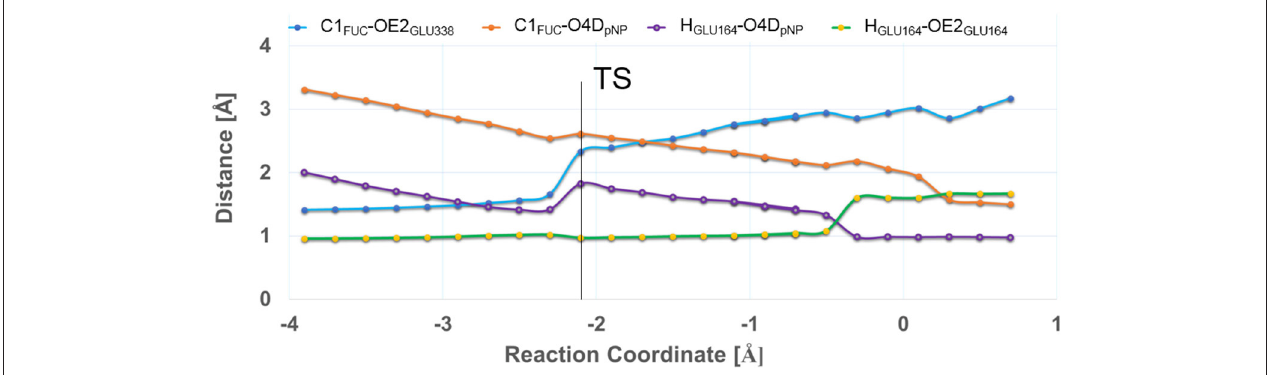
FIGURE 4 | Evolution of C1 FUC -O4D pNP (in blue), C1 FUC -OE2 GLU338 (in orange), H GLU164 -O4D pNP (in purple), and H GLU164 -OE2 GLU164 (in green) distances (in Å) along the glycosylation reaction. The results correspond to frame G I calculated with the QM(large)/MM partition and at the QM(PBE0/TZVP) level for the QM region.